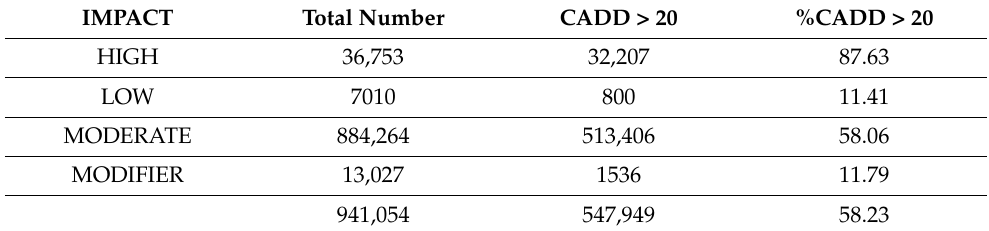
Table 1. Variants conservation score according to its impact class.